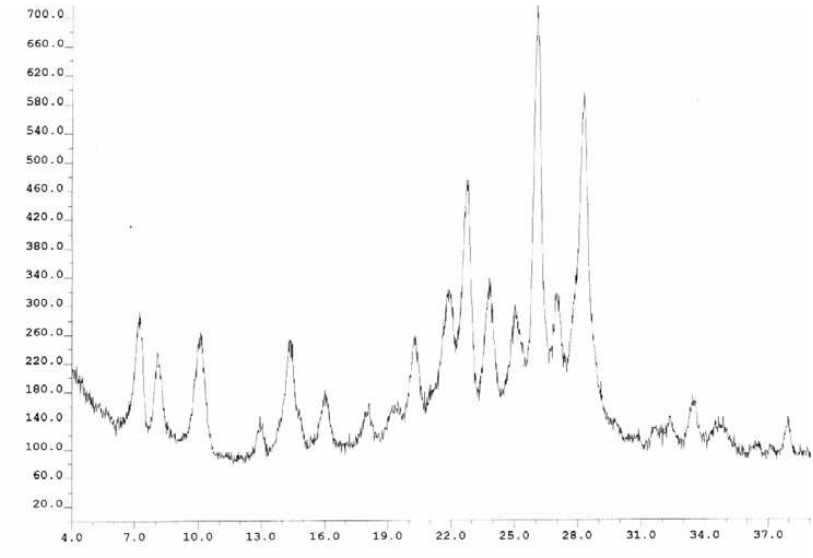
Fig. 1 The XRD pattern of MCM-22 as synthesized.